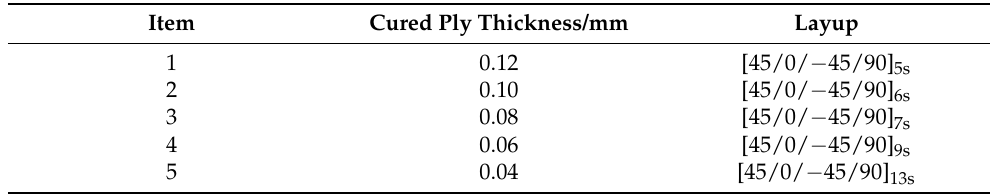
Table 4. Layups for different nominal cured ply thicknesses.